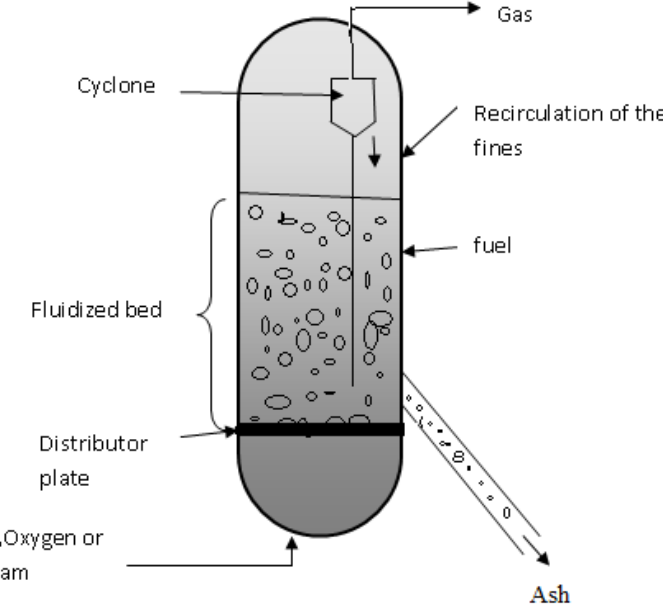
Figure 3. Fluidized bed gasifier model [52].